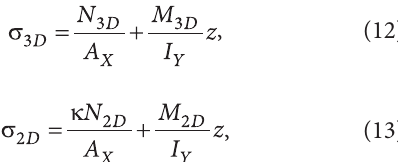
Table 3. Displacement u , mm, of bottom flange nodes